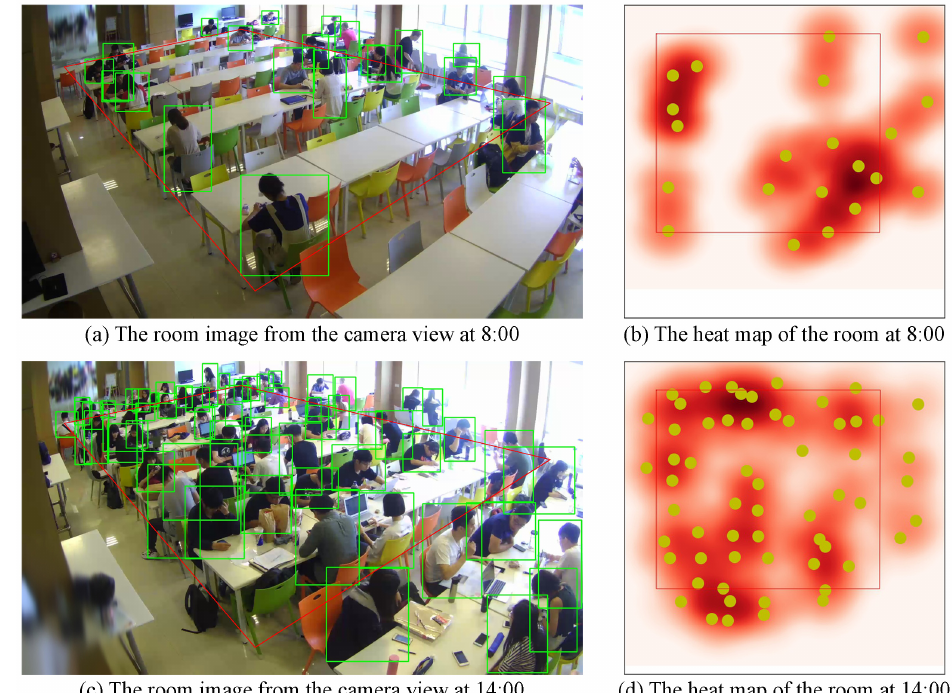
Figure 14. Heat map of reading room.